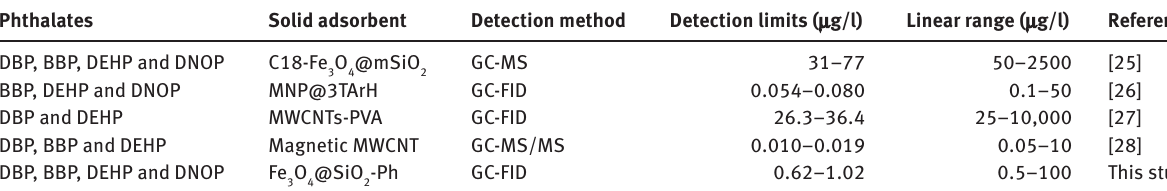
Table 4: Comparison of the developed method with other MDSPE methods in the determination of PEs. Phthalates Solid adsorbent Detection method Detection limits ( μ